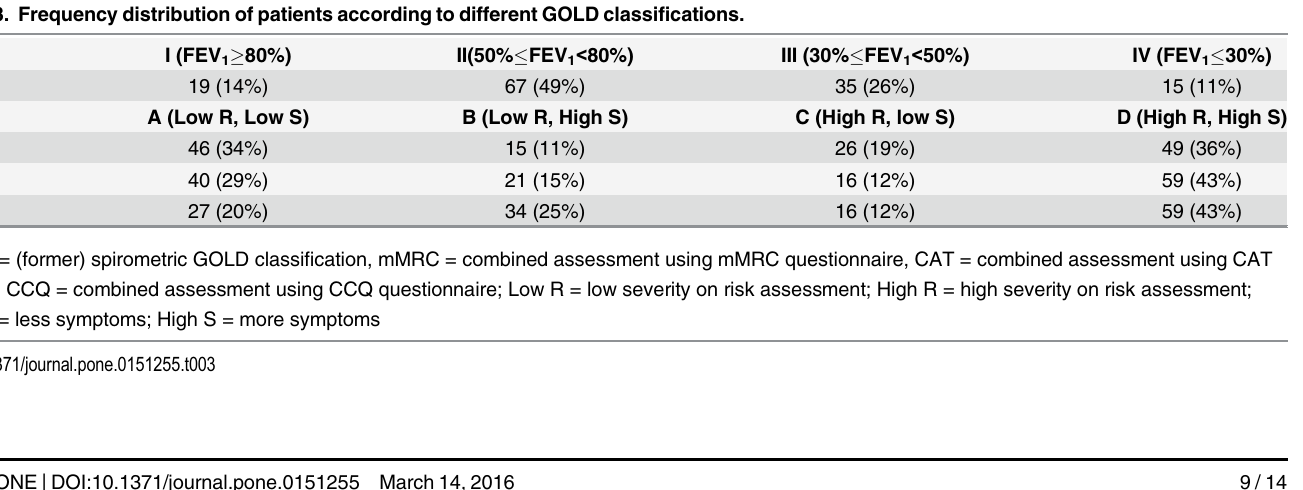
Table 3. Frequency distribution of patients according to different GOLD classifications.